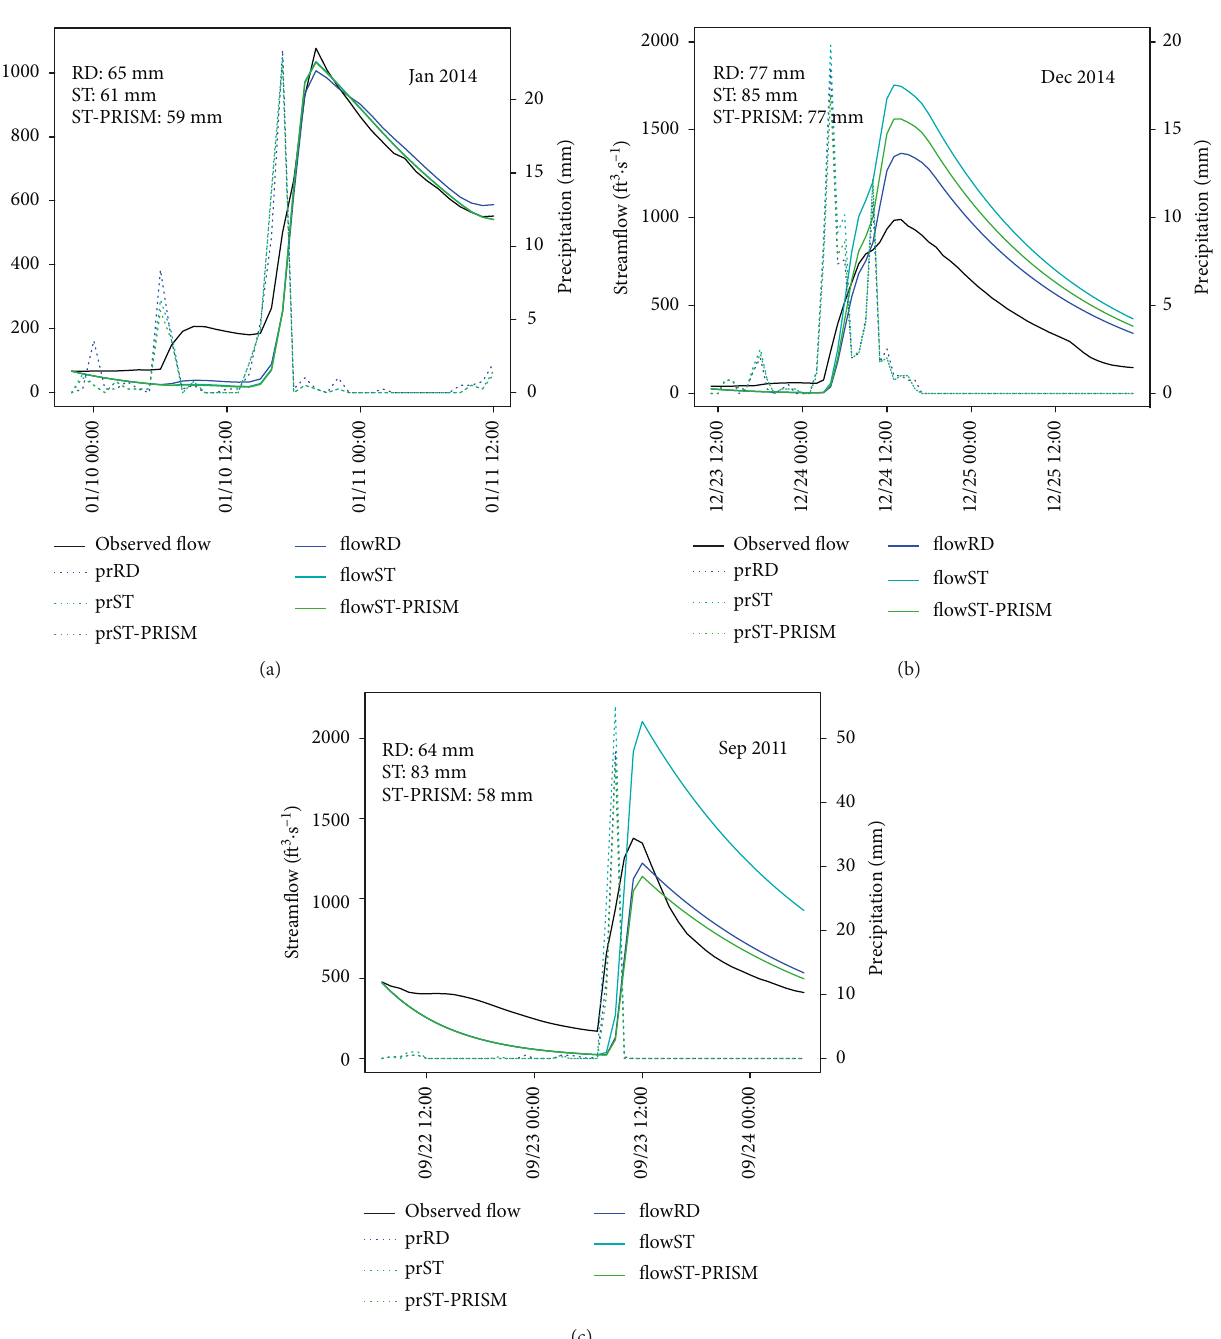
Figure 3: Observed and simulated streamflows (solid lines) in Gills Creek using three precipitation inputs (dash lines) for calibration (a) and two testing periods (b, c). ST: station observations, RD: radar data, and ST-PRISM: station observations adjusted by the gridded daily Parameter-elevation Relationships on Independent Slopes Model (PRISM) precipitation